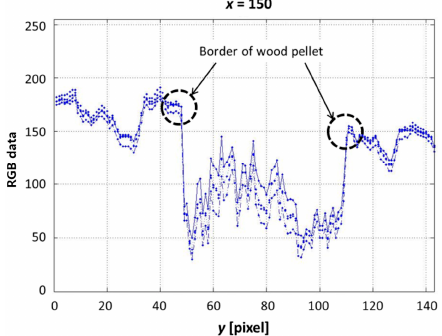
Figure 3. RGB data of image file of wood pellet (Figure 1) along y pixel at x = 150.